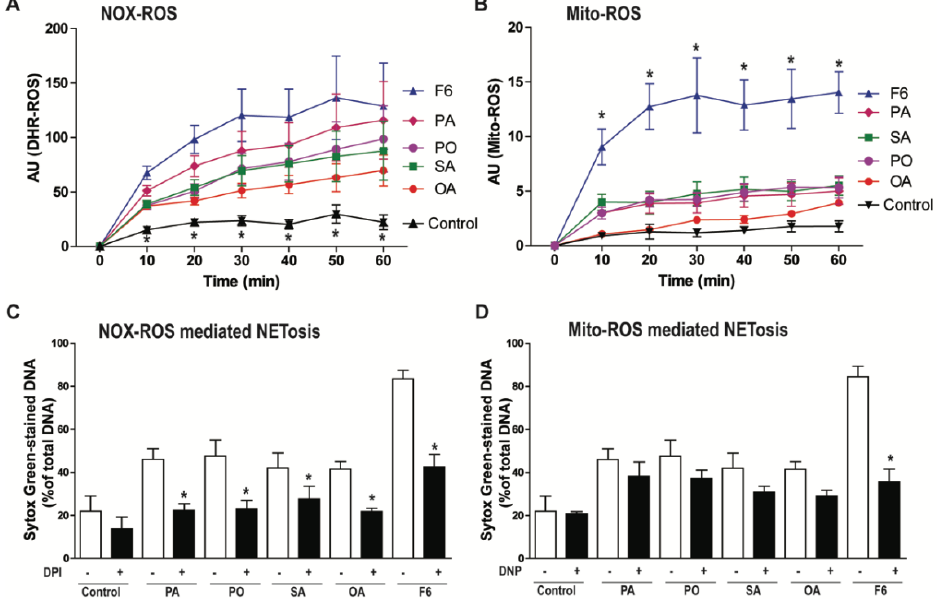
Figure 4. F6 modulates NETosis through both a NOX-dependent and NOX-independent pathway. ( A ) To confirm the involvement of NOX-mediated ROS production, a DHR123 assay was performed. Neutrophils were treated with cytosolic ROS indicator dye DHR123 and activated either with ethanol ( − ve control), 5 µ g/0.1 mL of PA, PO, SA, OA, or F6. ROS generation was assessed over 60 min post activation by a plate reader; ( B ) To examine the generation of mitochondrial ROS, MitoSox dye was used during the plate reader assay. Neutrophils were treated with MitoSox, a mitochondrial ROS indicative dye for 15 min, and activated either by ethanol ( − ve control), 5 µ g/0.1 mL of PA, PO, SA, OA, or F6 and the kinetics were assessed ( n = 3, * p < 0.05 comparing with control; two-way ANOVA with Bonferroni’s multiple comparison post -test); ( C , D ) To test the involvement of the NETosis pathway, neutrophils were pre-incubated either with NOX-inhibitor (DPI; 1 µ M) or mitochondrial ROS inhibitor (DNP; 25 µ M) for 1 h, followed by activation either with ethanol ( − ve control), 5 µ g/0.1 ml of PA, PO, SA, OA, or F6. The % DNA release data at 4 h of activation, show NETosis suppression by diphenyl iodonium (DPI) in neutrophils activated with PA, PO, SA, OA, or F6 (5 µ g/0.1 mL), while ( D ) 2,4-dinitrophenol (DNP) (ATP uncoupler; mitochondrial ROS inhibitor) only suppresses the NETosis induced by F6 ( n = 4, * p < 0.05 comparing between compound with and without inhibitors; independent t -test).